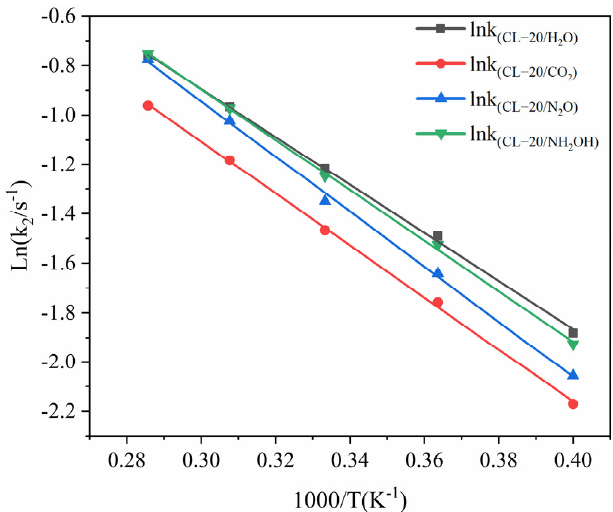
Figure 10. The logarithm of reaction rate (ln( k 1 /s − 1 )) against inverse temperature (1/T) in the exothermic decomposition stage at different temperatures. Thick trendline corresponds to the actual concentration data of corresponding matching color.